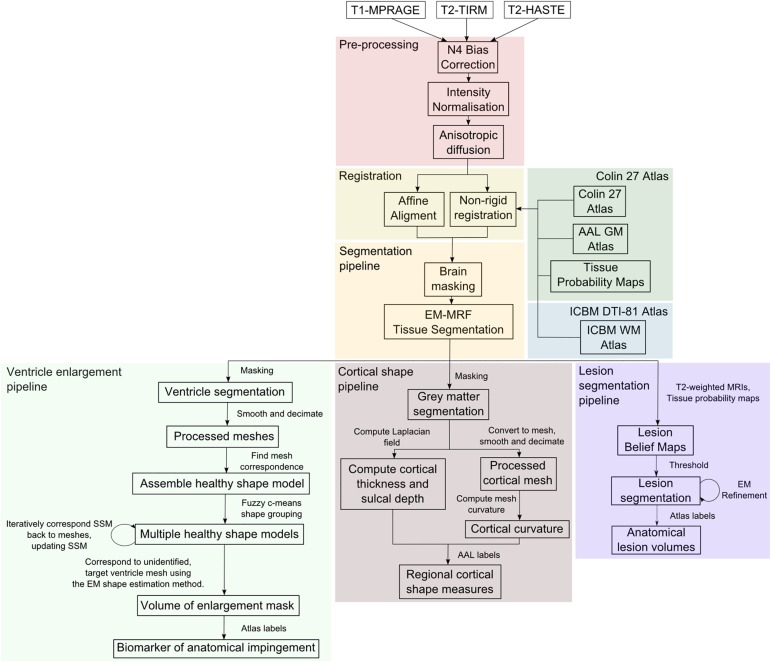
Illustration of the overall processing pipeline.The pre-processing steps are shown in red, registration steps in yellow, the utilised atlases in green and blue, and the brain masking and tissue segmentation approaches in orange which facilitate the detection of ventricular enlargement (shown in light green), cortical shape measures (in brown) and lesion burden (in purple).